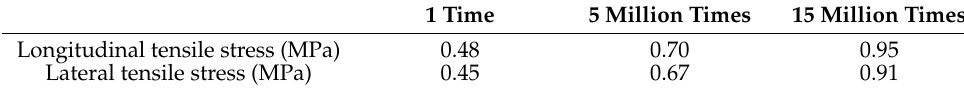
Table 4. Maximum stress of the base under working condition 1.